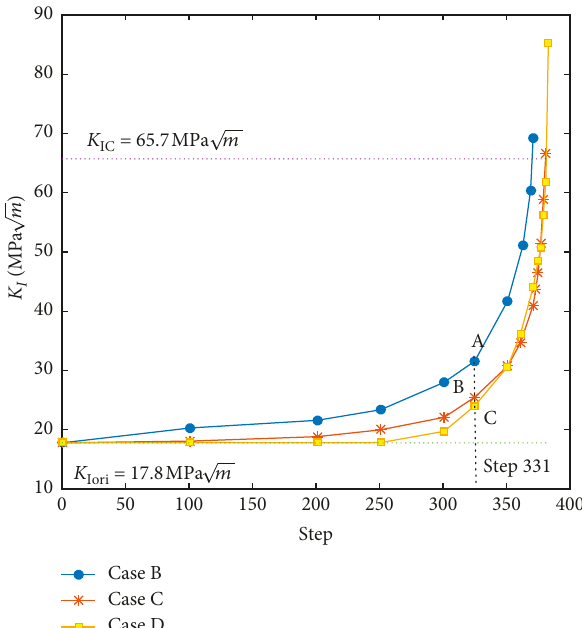
Figure 22: Time-varying curves of the stress intensity factor K steel wires corresponding to the cases in Figure 19. The original data of the table and figures in this section are provided in S2 File of the section “Supplementary